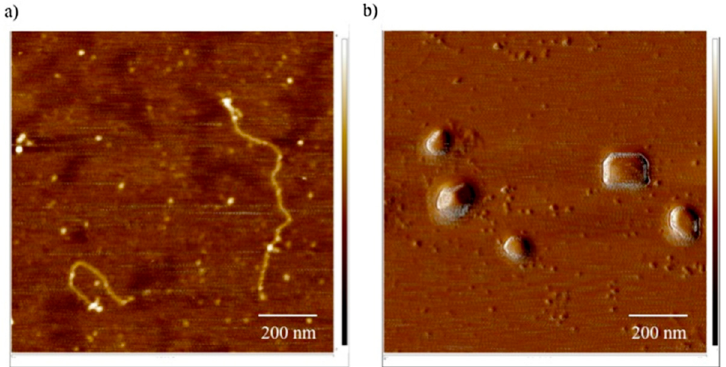
Figure 9. AFM images of DNA and DNA/chitosan complexes. ( a ) Single chains of DNA prepared in water at a concentration of 7.5 x 10 -3 g/L and ( b ) chitosan-DNA complexes formed at a charge ratio of 0.41 with 50 kDa chitosan in 0.01 M NaCl. Scale bar is 200 nm. Adapted with permission from Reference [154].